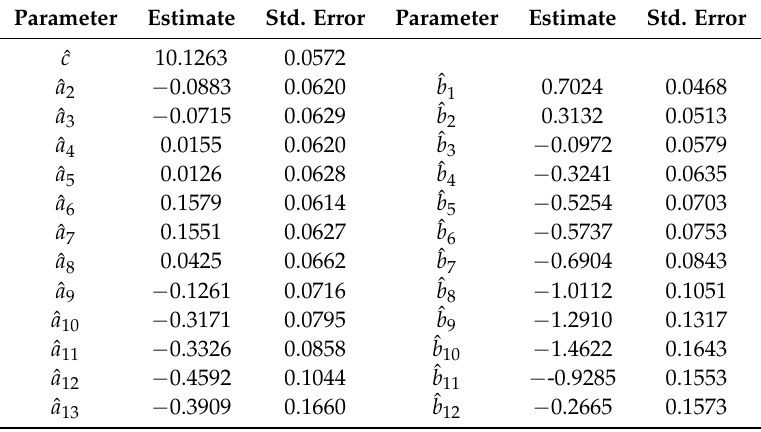
Table 3. Estimation of GLM parameter using the data in Table